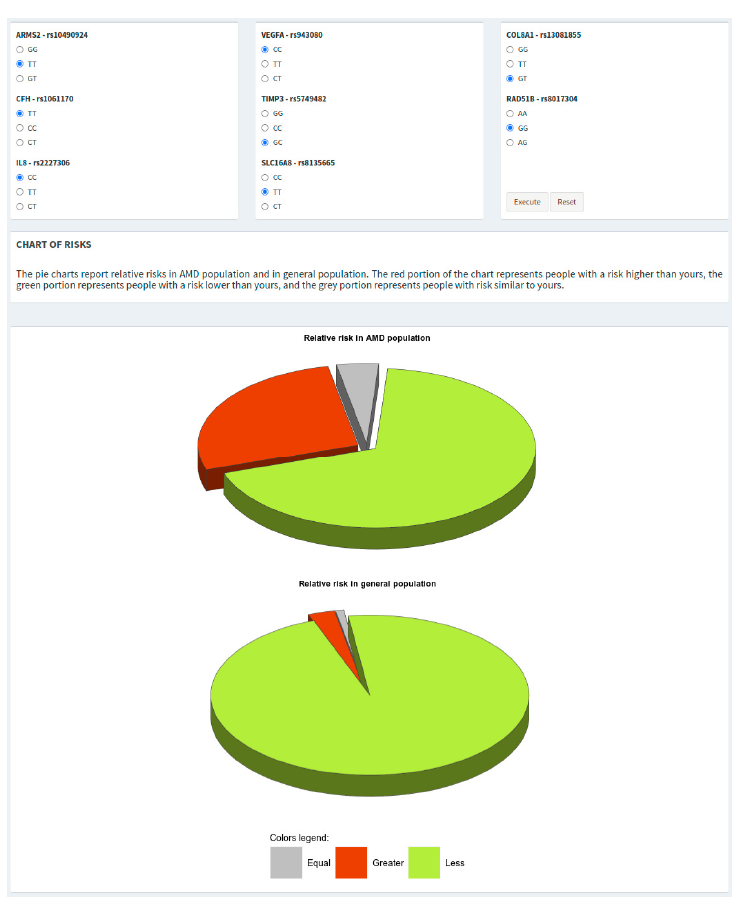
Figure 3. Genotypes grid and pie charts showing the risk of the individual with respect to both AMD and general populations.